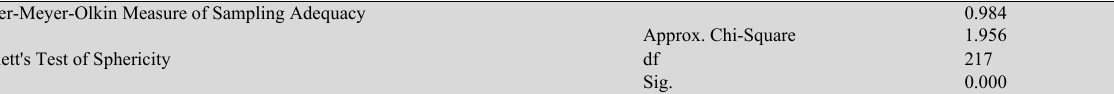
Table 6 Test results of KMO and Bartlett's Test. Kaiser-Meyer-Olkin Measure of Sampling Adequacy